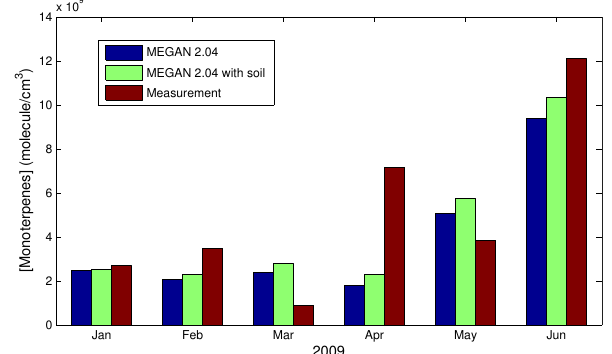
Figure 9. Modelled (MEGAN 2.04 without and with soil emissions) and measured (at the SMEAR II station) monoterpene concentra- tions at 4 m height in January–June